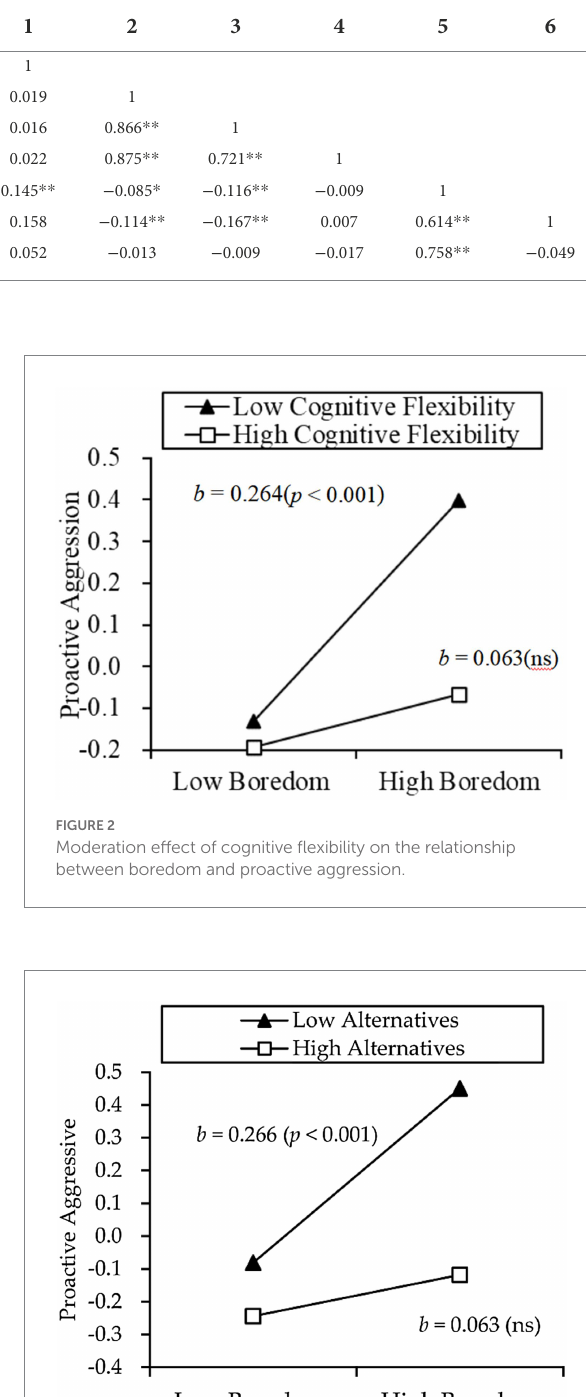
TABLE 1 Descriptive statistics and results of correlational analysis.